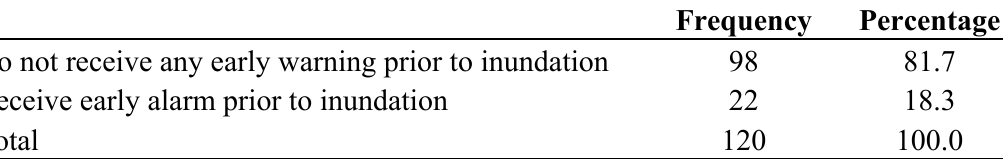
Table 7. Response to early warnings prior to coastal inundation.